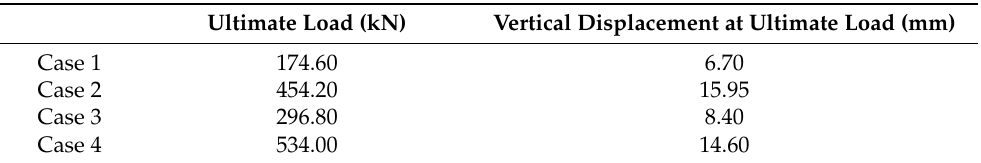
Figure 5. Load–displacement curves of prefabricated shoring systems.